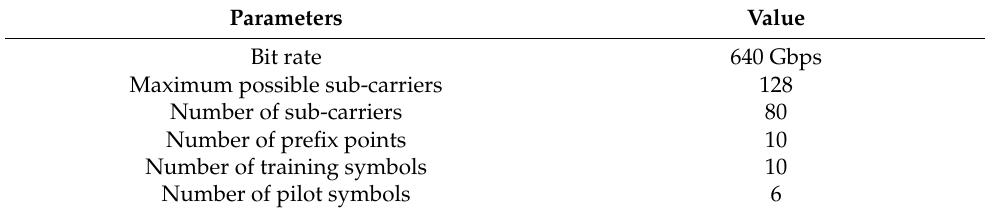
Table 1. The experiment parameters. Parameters Value Bit rate 640 Gbps Maximum possible sub-carriers 128 Number of sub-carriers